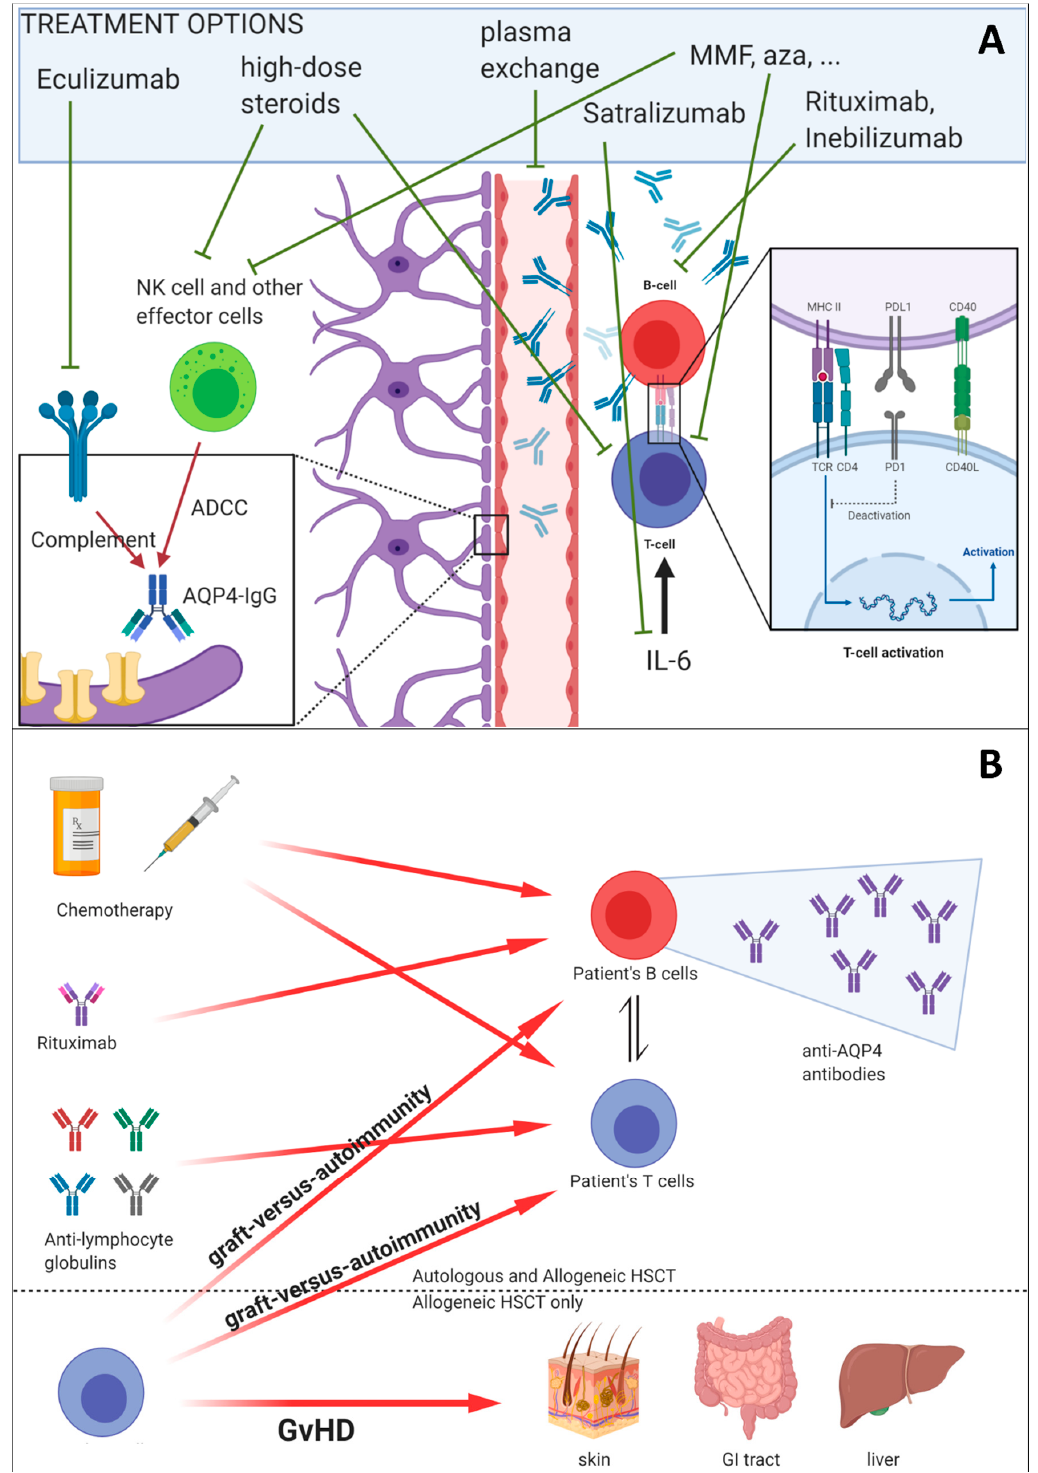
Figure 2. ( A ) Schematic representation of neuromyelitis optica spectrum disorder (NMOSD) pathogenesis: currently available treatments and their targets are reported. ADCC, antibody-dependent cell-mediated cytotoxicity; AQP4-IgG, anti-aquaporin-4 immunoglobulin G; NK, natural killer; MMF, mycophenolate mofetil; aza, azathioprine. ( B ) Allogeneic HSCT rationale and immunological implications.